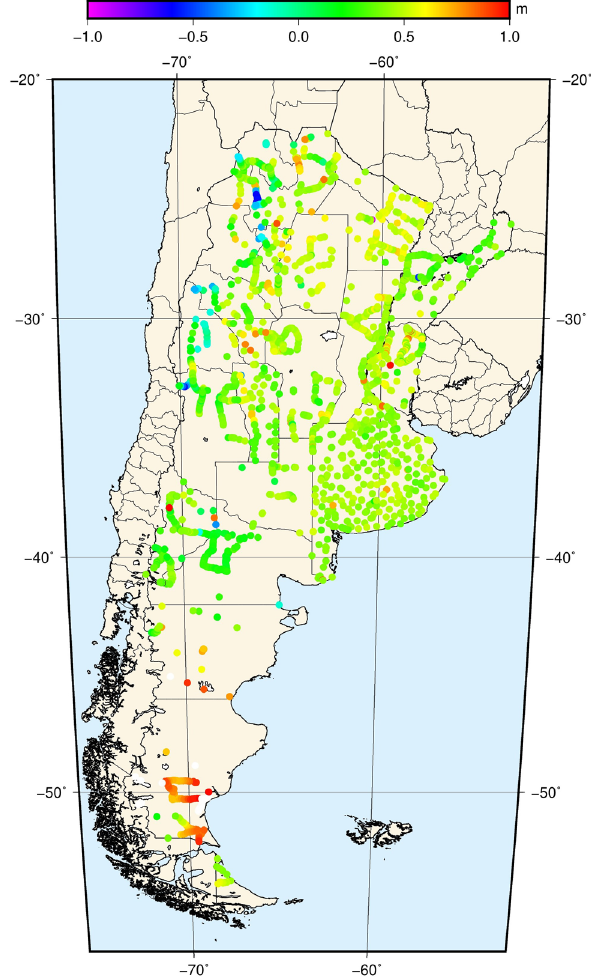
Figure 5: Di ff erences between geoid undulations derived from GPS/ levelling and N Grav at di ff erent